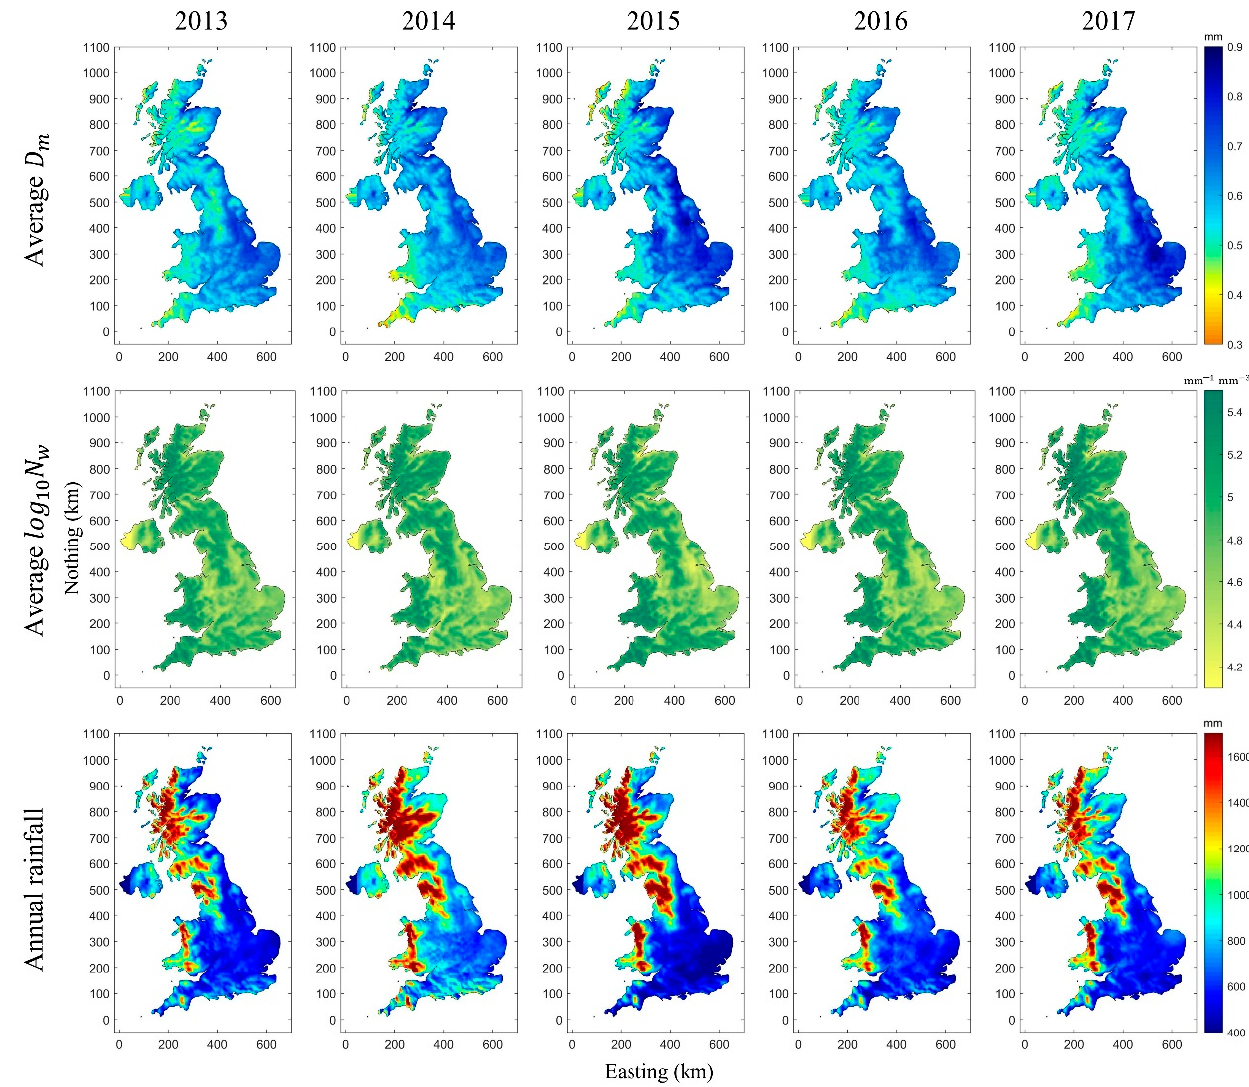
Figure 3. Spatial distribution of the average value of D m and log 10 N w and annual rainfall across the UK from 2013 to 2017 under the Morrison